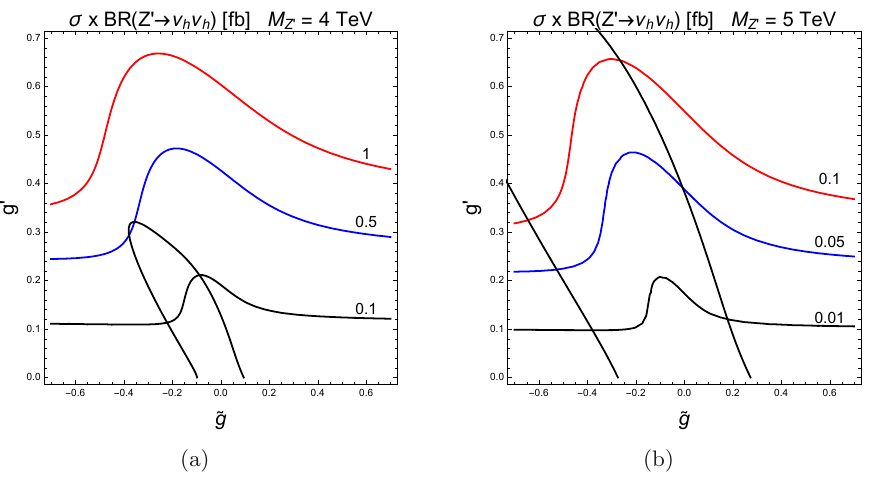
Figure 5 . Contour plots of the cross section times BR for the process pp with √ S = 13 TeV in the (˜ g, g ′ ) plane. The limit m ν